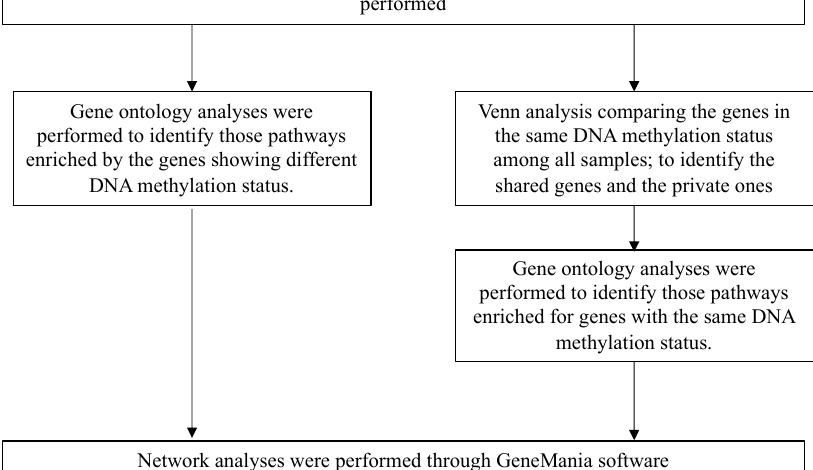
Figure 8. Experimental pipeline of the methylation-sensitive amplified polymorphism (MSAP) and next-generation sequencing (NGS) combined approach.